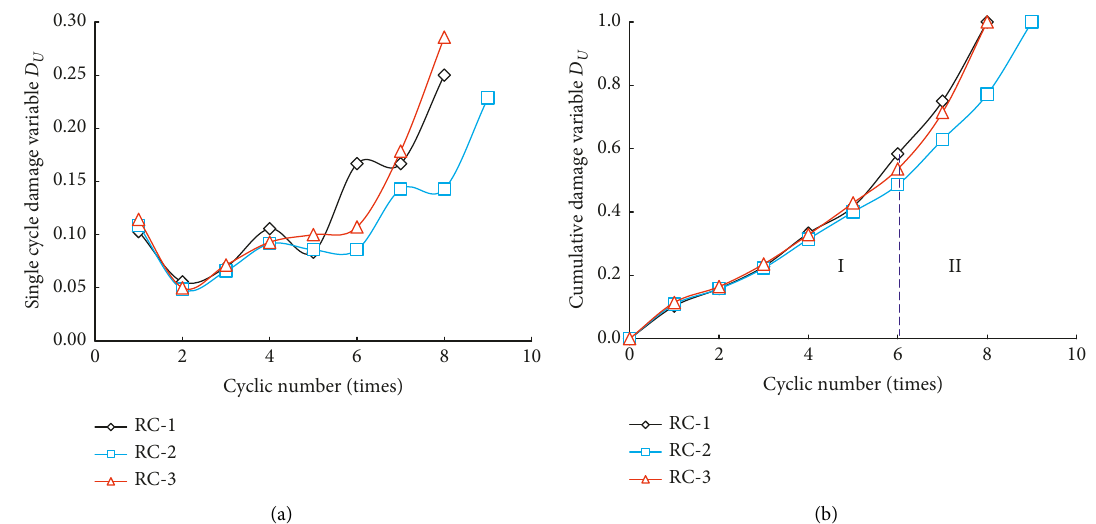
Figure 7: Damage variable curve based on energy dissipation. (a) D